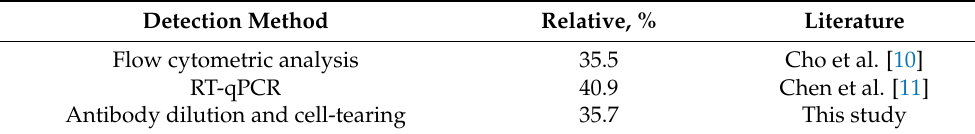
Table 5. Data of relative antigens expression on RBC surface in the works of